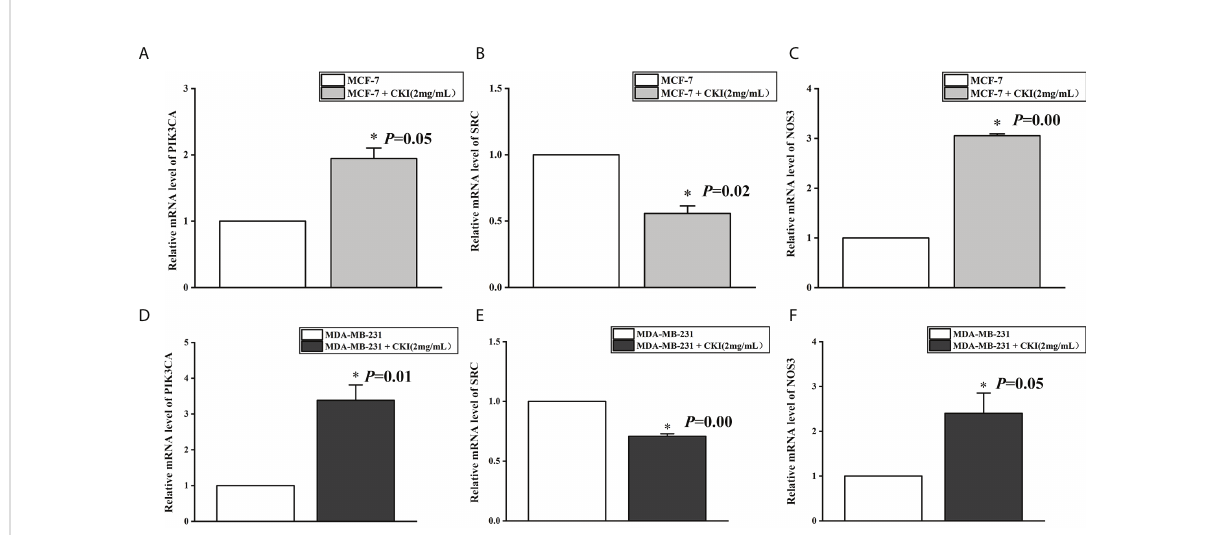
FIGURE 10 The mRNA expression of PIK3CA, SRC and NOS3 in MCF-7 cells and MDA-MB-231 cells. Notes: (A) The expression levels of PIK3CA mRNA in MCF-7 cells; (B) The expression levels of SRC mRNA in MCF-7 cells; (C) The expression levels of NOS3 mRNA in MCF-7 cells; (D) The expression levels of PIK3CA mRNA in MDA-MB-231 cells; (E) The expression levels of SRC mRNA in MDA-MB-231 cells; (F) The expression levels of NOS3 mRNA in MDA-MB-231 cells. n=3. Data are presented as means ± SD. * P < 0.05, compared with MCF-7(MDA-MB-231) group.